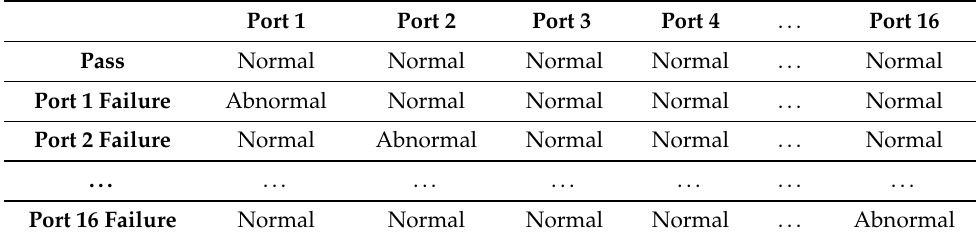
Table 4. Specific port failure classification criteria for array antennas.